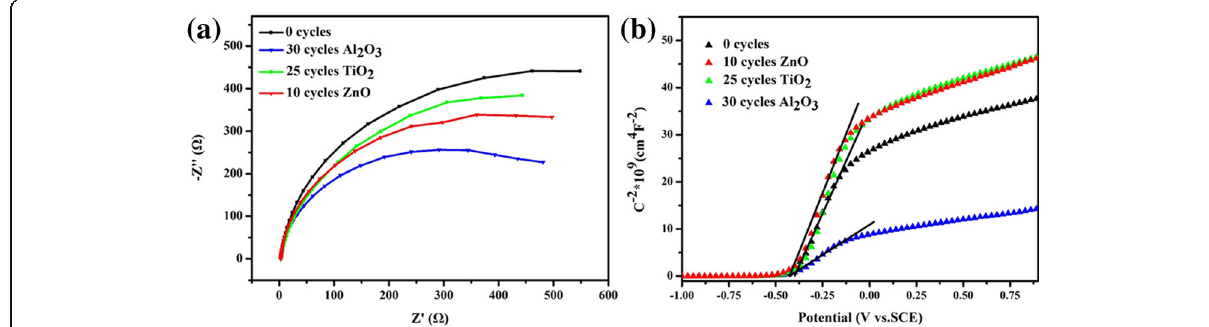
Fig. 7 a EIS spectra of the TNTAs/QDs, TNTAs/QDs/10 cycles ZnO, TNTAs/QDs/25 cycles TiO 2 , and TNTAs/QDs/30 cycles Al 2 O 3 electrodes. b Mott-Schottky analysis of the TNTAs/QDs, TNTAs/QDs/10 cycles ZnO, TNTAs/QDs/25 cycles TiO 2 , and TNTAs/QDs/30 cycles Al 2 O 3